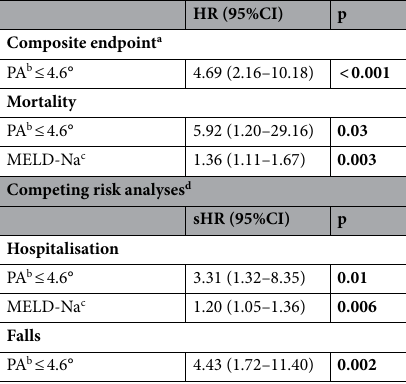
Table 4. Multivariable analyses. Independent predictive factors for the composite endpoint, mortality, hospitalisation and falls at 2-year follow-up in all patients. P values in bold indicate statistical significance. Discriminative ability for composite endpoint: estimated C-index 68.2%, after bootstrap 68.3%; for mortality: estimated C-index 88.4%, after bootstrap 85.7%; for hospitalisation: estimated C-index 72.8%, after bootstrap 72.1%; for falls: estimated C-index 67.4%, after bootstrap 67.8%. a Endpoint including hospitalisation, long- term care centre admission, falls, or death. b PA: phase angle. c MELD-Na: model for end-stage liver disease- sodium. d Death as competing event.